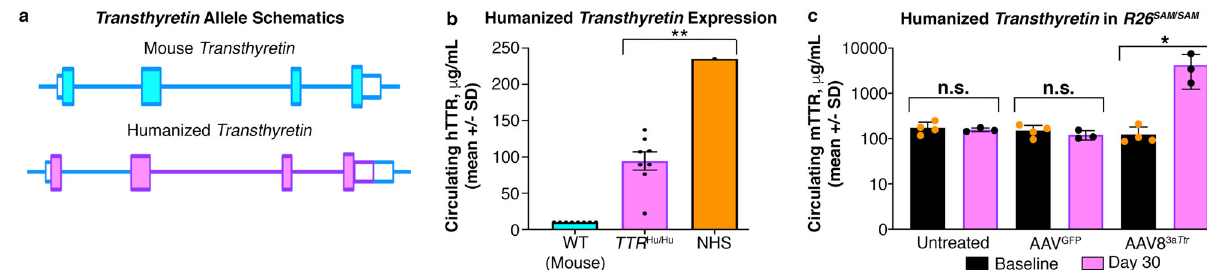
Fig. 6 In vivo applications of R26 SAM gene modulation. a Schematic of murine Ttr replaced with WT human TTR sequence. Mouse sequences are represented by blue lines and human sequences by purple. b Circulating mouse and human TTR levels were determined by species-speci fi c ELISA and plotted as mean + / − SD ( n = 8). Commercial normal human serum (NHS) was run as a control for normal human expression levels ( n = 1). Humanized allele vs NHS: p = 0.0071. c Homozygous humanized TTR mice were crossed to R26 SAM / SAM mice and injected with AAV8 3a Ttr or AAV8 GFP ( n = 4). Asterisks (*) indicates signi fi cance, and the number of asterisks indicates the number of 0s after the decimal point. One-tailed, unpaired Student ’ s t -test for ( b , c